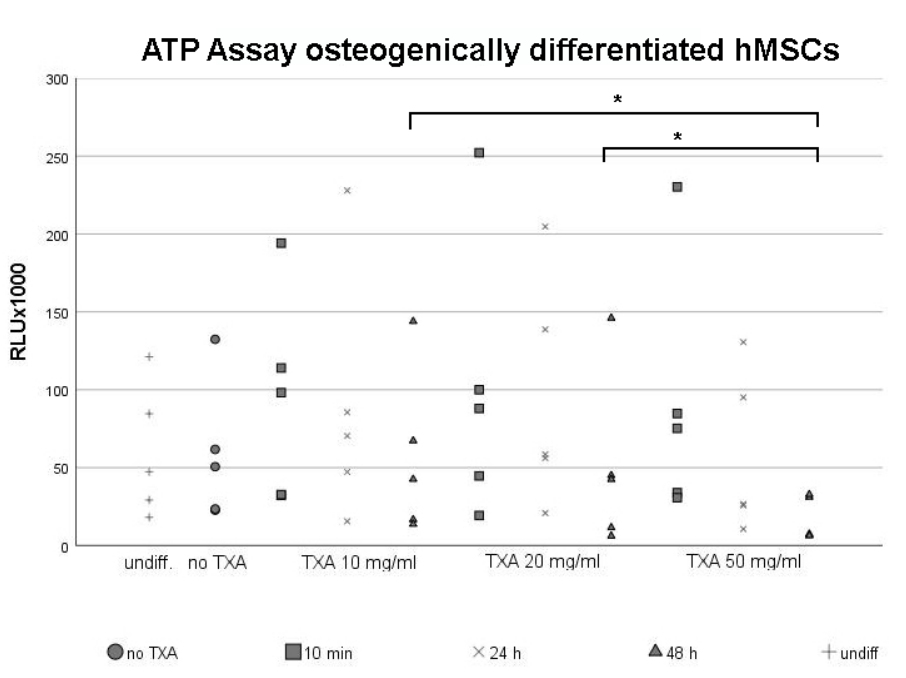
Figure 2. ATP assay of mesenchymal stromal cells following osteogenic di ff erentiation and treatment with 50 mg / mL tranexamic acid for varying exposure times. Osteogenic di ff erentiation was induced in primary hMSCs harvested from five di ff erent donors using an osteogenic di ff erentiation medium for 21 d. Undi ff erentiated control samples (undi ff .) were maintained for comparison. After 21 d of osteogenesis, MSCs were exposed to 0 mg / mL (no TXA), 10 mg / mL, 20 mg / mL or 50 mg / m of TXA. Cells were exposed to TXA for 10 min, 24 h or 48 h. Cell proliferation was evaluated using the ATP assay. Each dot represents a single value from all five examined donor samples after treatment with di ff erent concentrations of TXA for indicated exposure times. * Significant di ff erence ( p < 0.05) compared to control samples. hMSCs, human mesenchymal stromal cells; TXA, tranexamic acid; min, minutes; d, days; h,